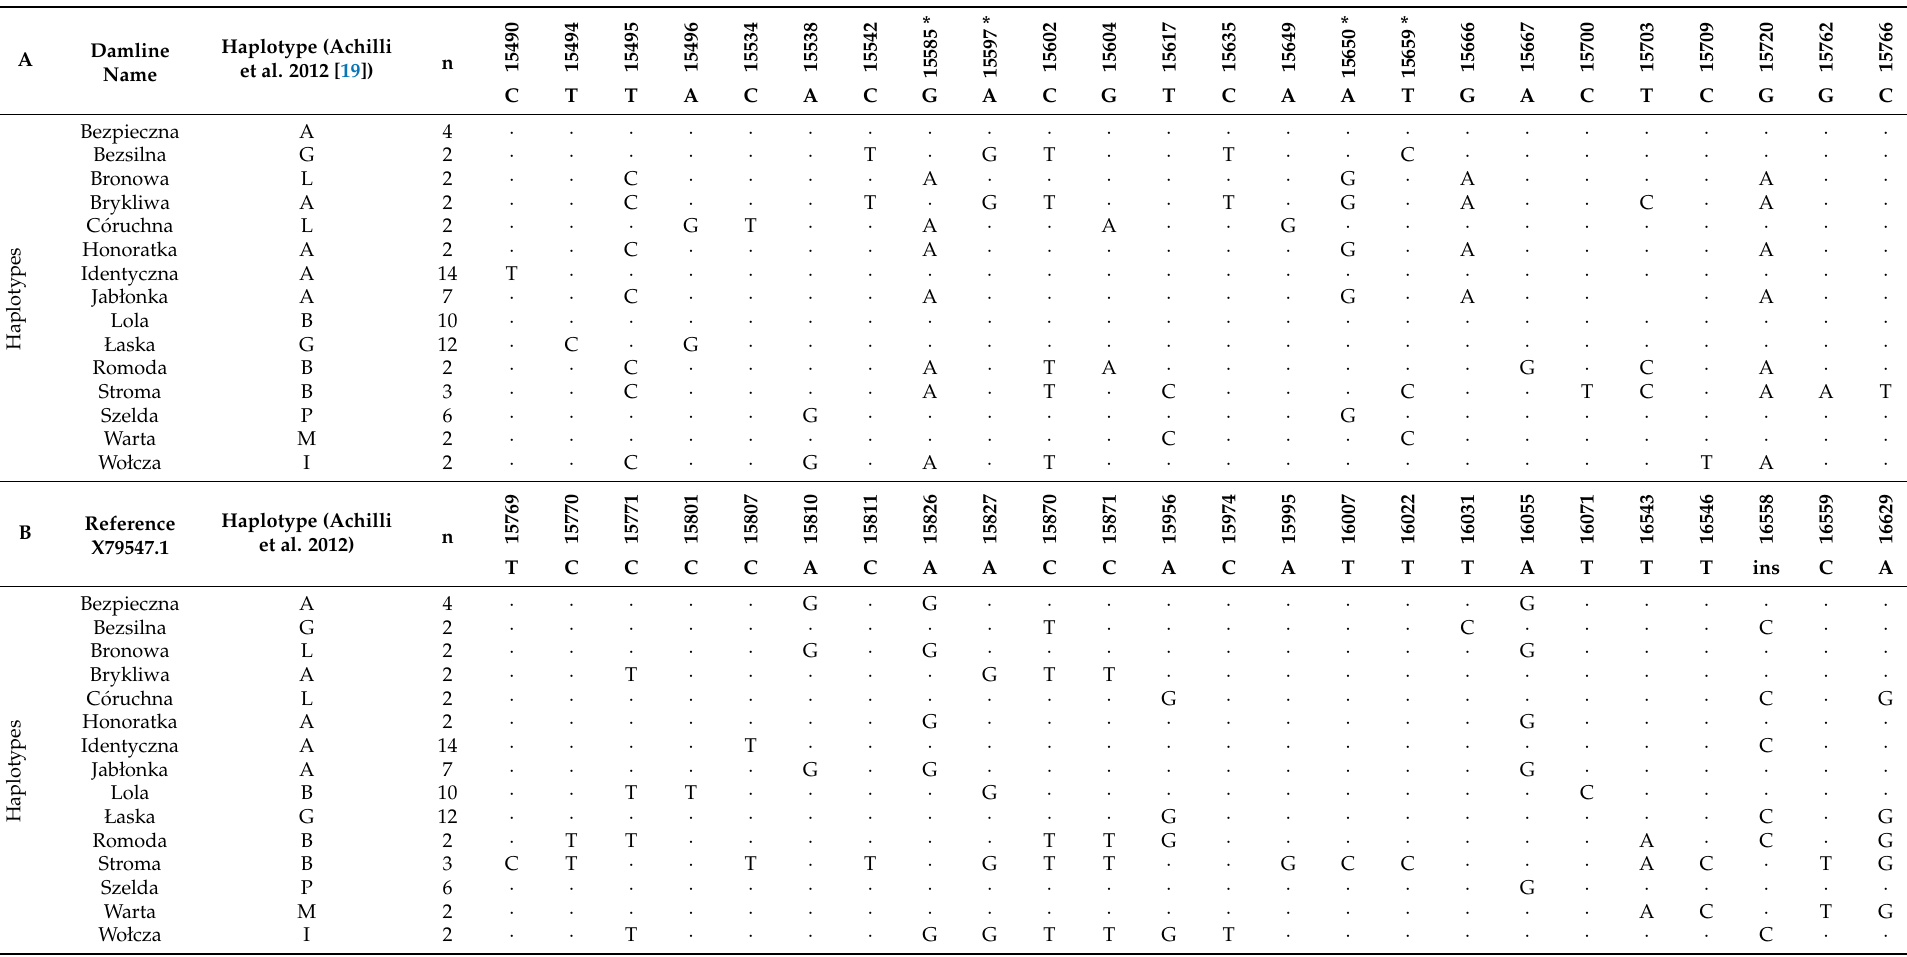
Table 2. A: All Polish draft horse haplotype sequences used in the study with the Single Nucleotide Polymorphisms (SNPs) between positions 15490 and 15766, compared with the reference sequence X79547.1. *—hotspots; ·—no differences. B: All Polish draft horse haplotype sequences used in the study with the Single Nucleotide Polymorphisms (SNPs) between positions 15769 and 16629, compared with the reference sequence X79547.1; ·—no